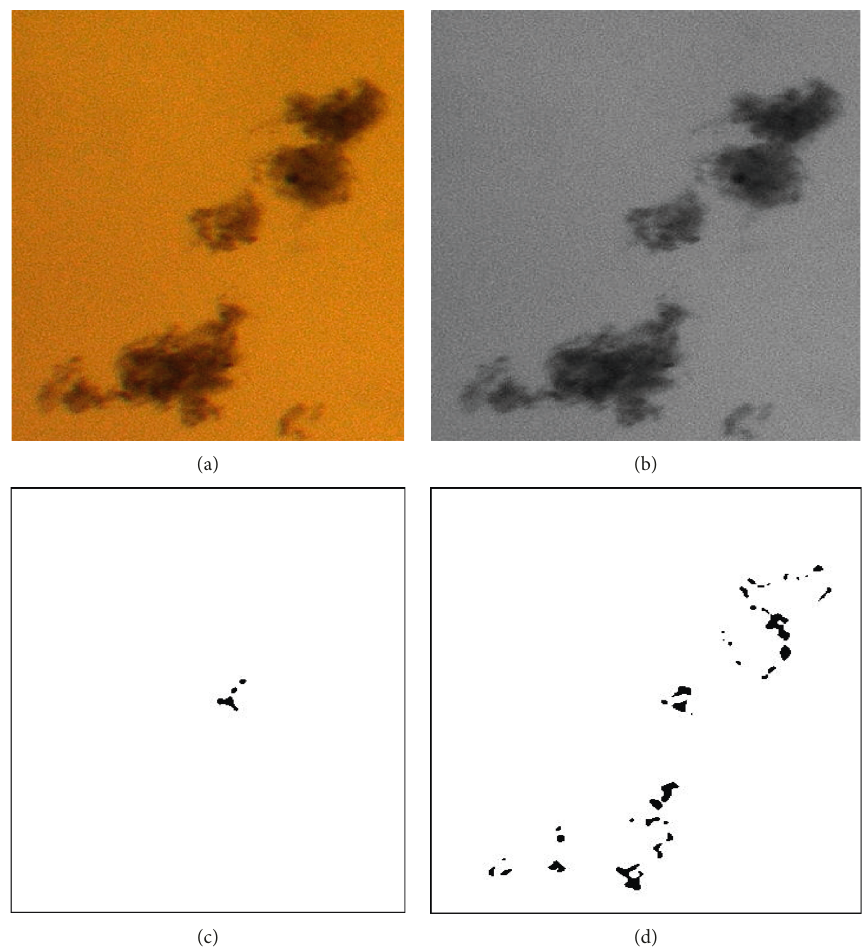
Figure 8: Image 5 segmentation results: (a) original image, (b) grayscale image, (c) segmentation results using Canny, and (d) segmentation results using our